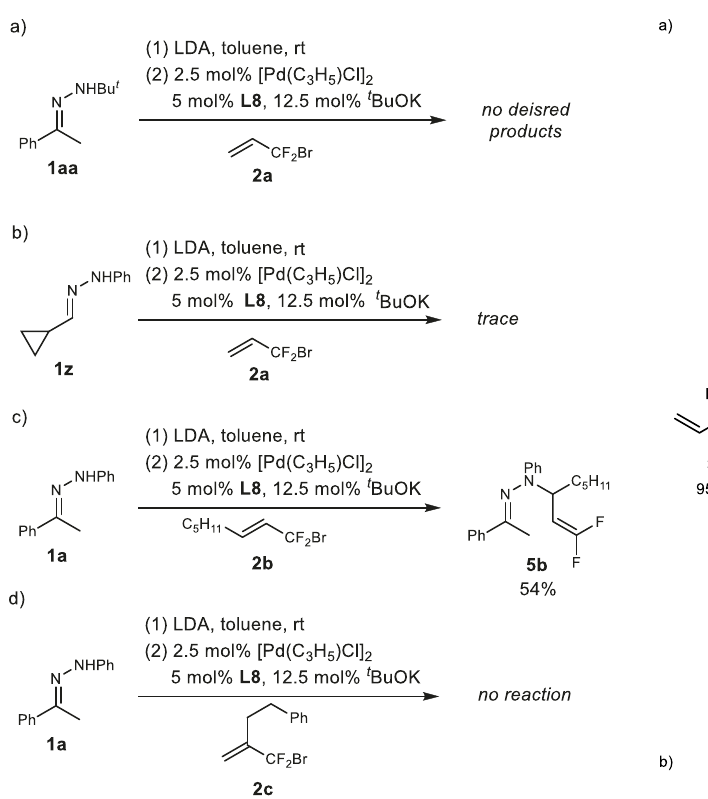
Fig. 6 Examples of unsuccessful palladiumd-catalyzed asymmetric umpolung di fl uoroallylation. a Palladium-c-atalyzed reaction of N-tert -Bu hydrazone 1aa with BDFP. b Palladium-catalyzed reaction of hydrazone 1z with BDFP using L8 as the ligand. c Palladium-catalyzed reaction of hydrazone 1a with ( E )-1-bromo-1,1-di fl uorooct-2-ene ( 2b ). d Palladium- catalyzed reaction of hydrazone 1a with (3-(bromodi fl uoromethyl)but-3- en-1-yl)benzene ( 2c ).